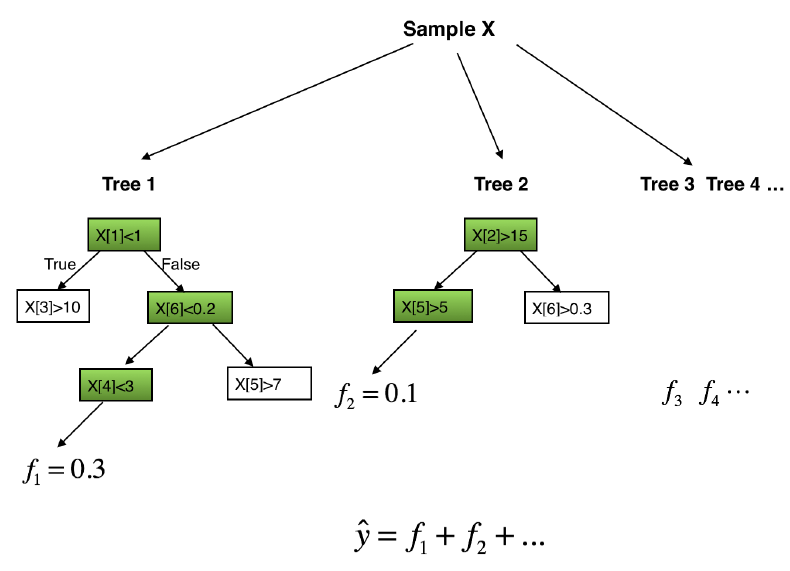
Figure 1. Tree Ensemble Model. The final prediction ˆ y for an instance x i is the sum of predictions from each